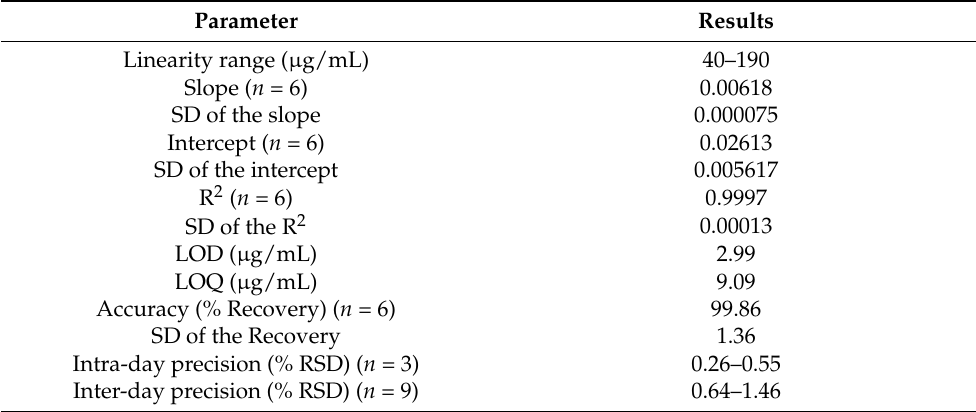
Table 1. Parameters of LC-UV method for the quantitative determination of vildagliptin. Parameter